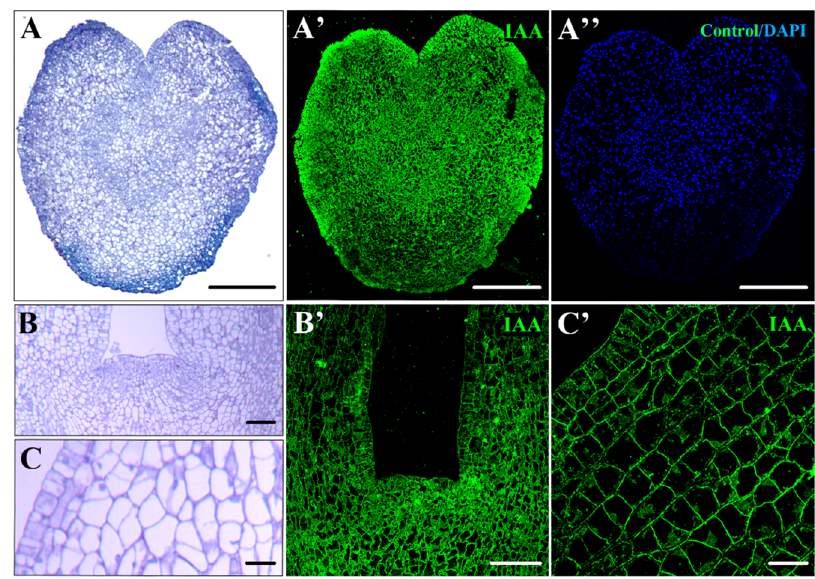
Figure 4. Immunolocalization of IAA at advanced stages of development of somatic embryos. ( A , B , C ) Micrographs of semithin sections stained by Toluidine blue: the heart ( A ); shoot apical meristem ( B ); and cotyledon of the torpedo embryo ( C ). ( A’ , B’ , C’ ) Confocal microscopy images of IAA immunofluorescence (green signal) of the heart ( A’ ); shoot apical meristem ( B’ ); and cotyledon of the torpedo embryo ( C’ ). ( A” ) Negative control omitting the primary antibody. Bars represent: ( A , A’ , A’’ ) 250 µm, ( B ) 125 µm, ( B’ ) 75 µm, ( C , C’ ) 25 µm.